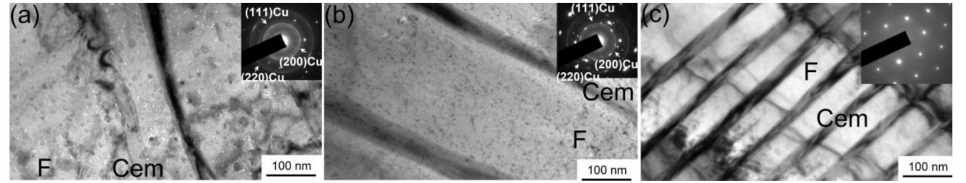
Figure 7. Copper precipitates in the specimens cooled at ( a ) 0.5 ◦ C / s, ( b ) 3 ◦ C / s, and ( c ) 7 ◦ C / s characterized using TEM.